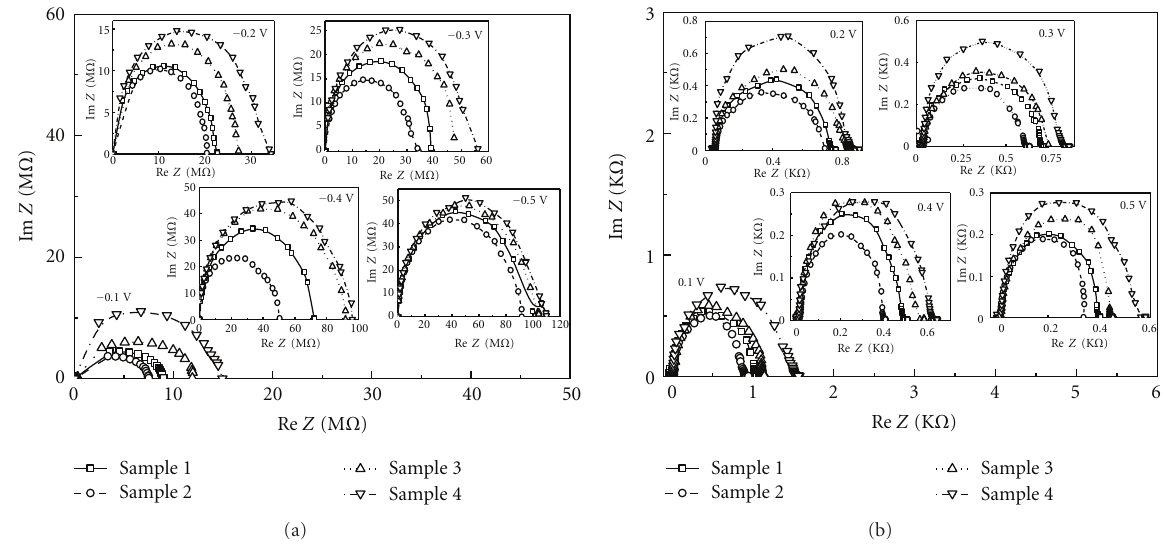
Figure 8: Cole-Cole plot of a-Si solar cell at di ff erent (a) reversed biases ( − 0.1V ∼ − 0.5 V) and (b) forward biases (0.1V ∼ 0.5V) conditions.